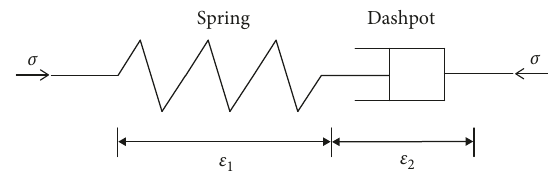
Figure 12: Schematic diagram the of Maxwell model.